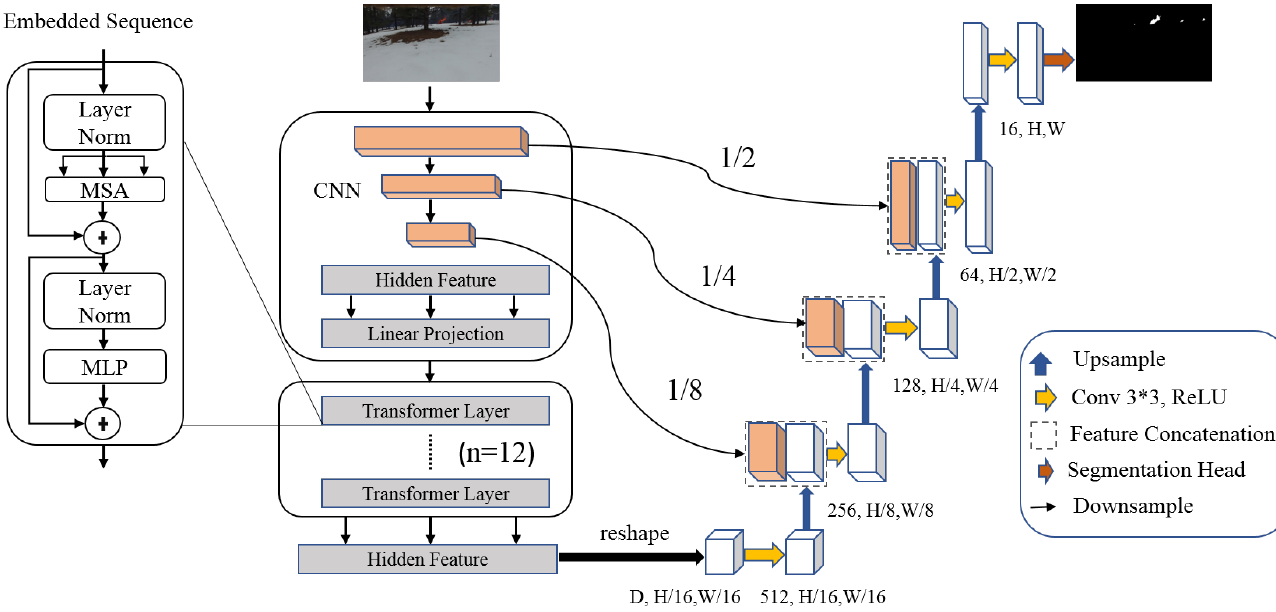
Figure 2. The proposed TransUNet